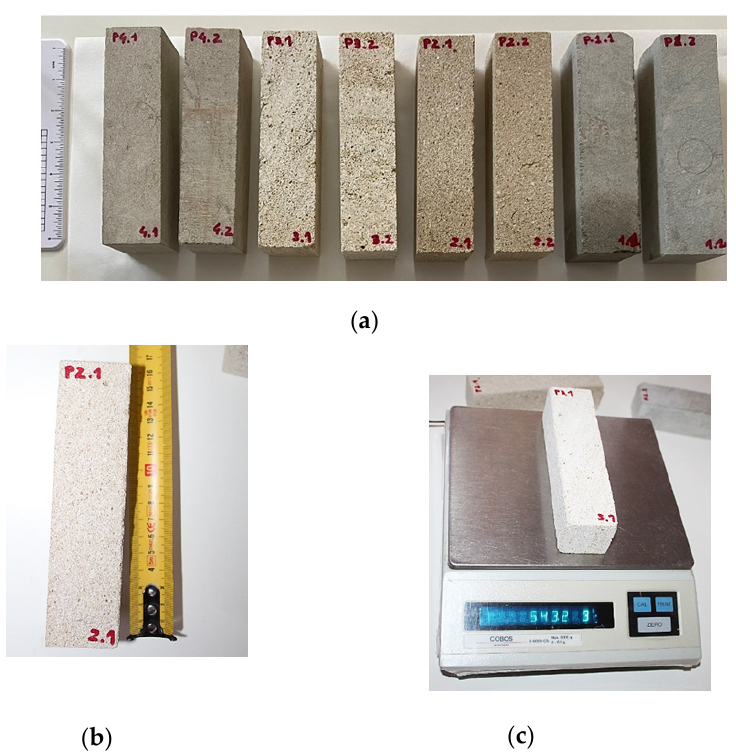
Figure 3. ( a ) Bateig stone specimens: Blue variety (P1.1/P1.2); Beige Hydra variety (P2.1/P2.2); Cream Maroc variety (P3.1/P3.2); Diamante variety (P4.1/P4.2). ( b ) Check of the geometric regularity and ( c ) sample weighing.